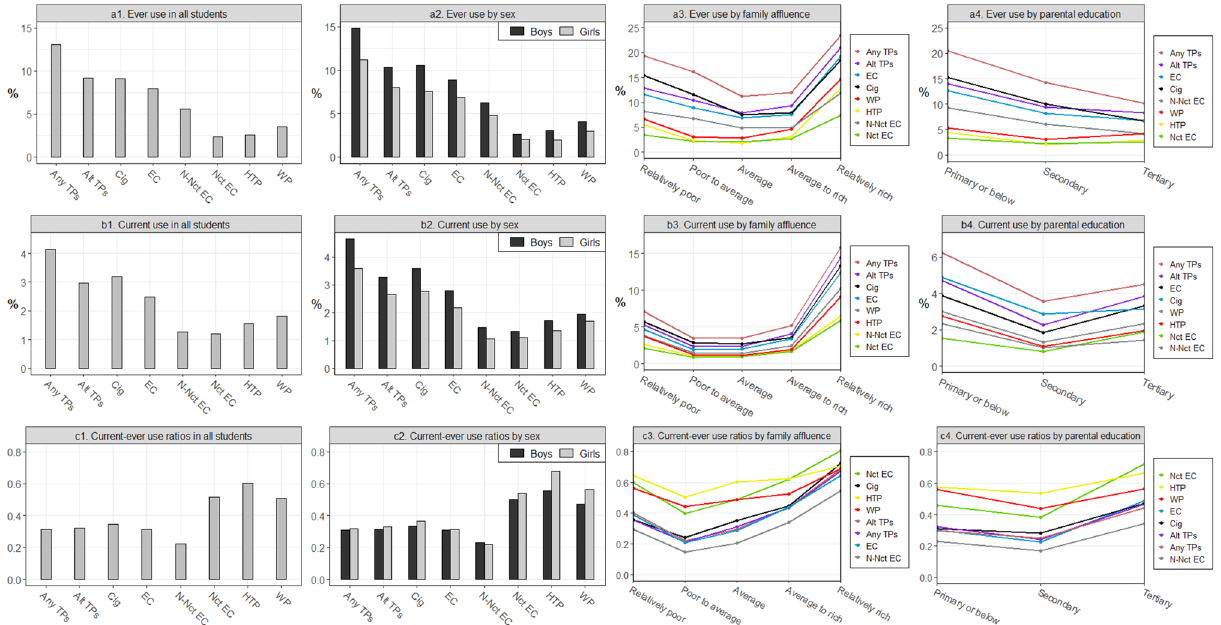
Figure 1. Use of various tobacco products in Hong Kong secondary school students by sociodemographic factors. TP, tobacco product; Alt TP, alternative tobacco product; Cig, cigarette; EC, e-cigarette; N-Nct, non- nicotine; Nct, nicotine; HTP, heated tobacco product; WP, waterpipe. Note : In line graphs, the position of legends was aligned with the rank of the last value on each line. All percentages were weighted by sex, age, and grade distribution of the target population provided by the Education Bureau of the Government of the Hong Kong Special Administrative